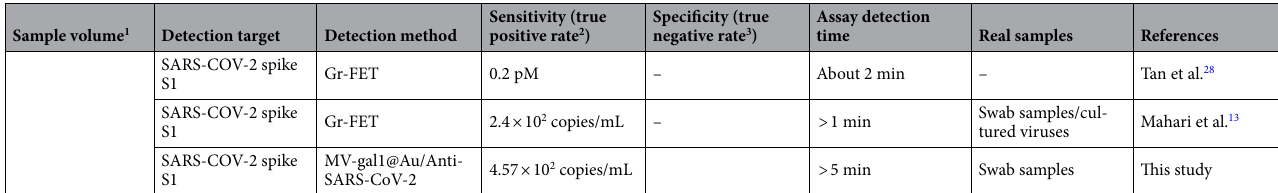
Table 1. Comparison the biosensor methods to detection of surface antigen of SARS-COV2. 1 The sensitivity of a clinical test refers to the ability to correctly identify those patient samples (also called the true positive rate) (Lalkhen and McCluskey 30 ). 2 The specificity of a clinical test refers to the ability to correctly identify those non-patient samples (also called true negative rate) (Lalkhen and McCluskey 30